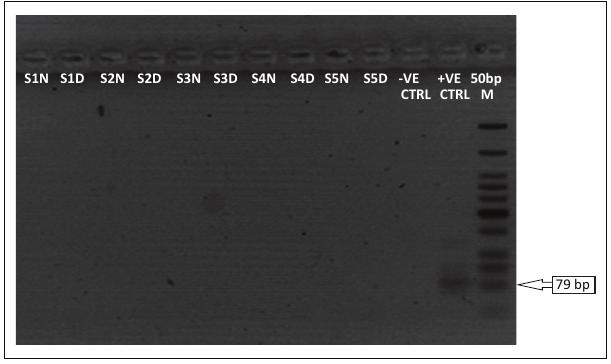
bp, base pair. FIGURE 2: Reverse transcription polymerase chain reaction detection of Dengue virus, Lagos, Nigeria, March 2018. The gel lanes represent neat (undiluted, N) and 1:10 dilutions (D) of the RNA extracts used. Three Nigerian outbreak samples representing lanes S1–S3 (accession numbers: MF317933-35) were run alongside Benin Republic outbreak samples (S4–S5). RNase/DNase free water was used as negative extraction control (-VE CTRL) while a tissue culture inactivated sample of Dengue virus from the Virology Unit Laboratory of the Bernhard Nocht Institute of Tropical Medicine, Germany was used as a positive control (+VE CTRL).